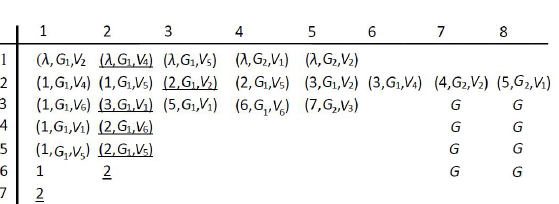
Fig. 14 Database graphs.